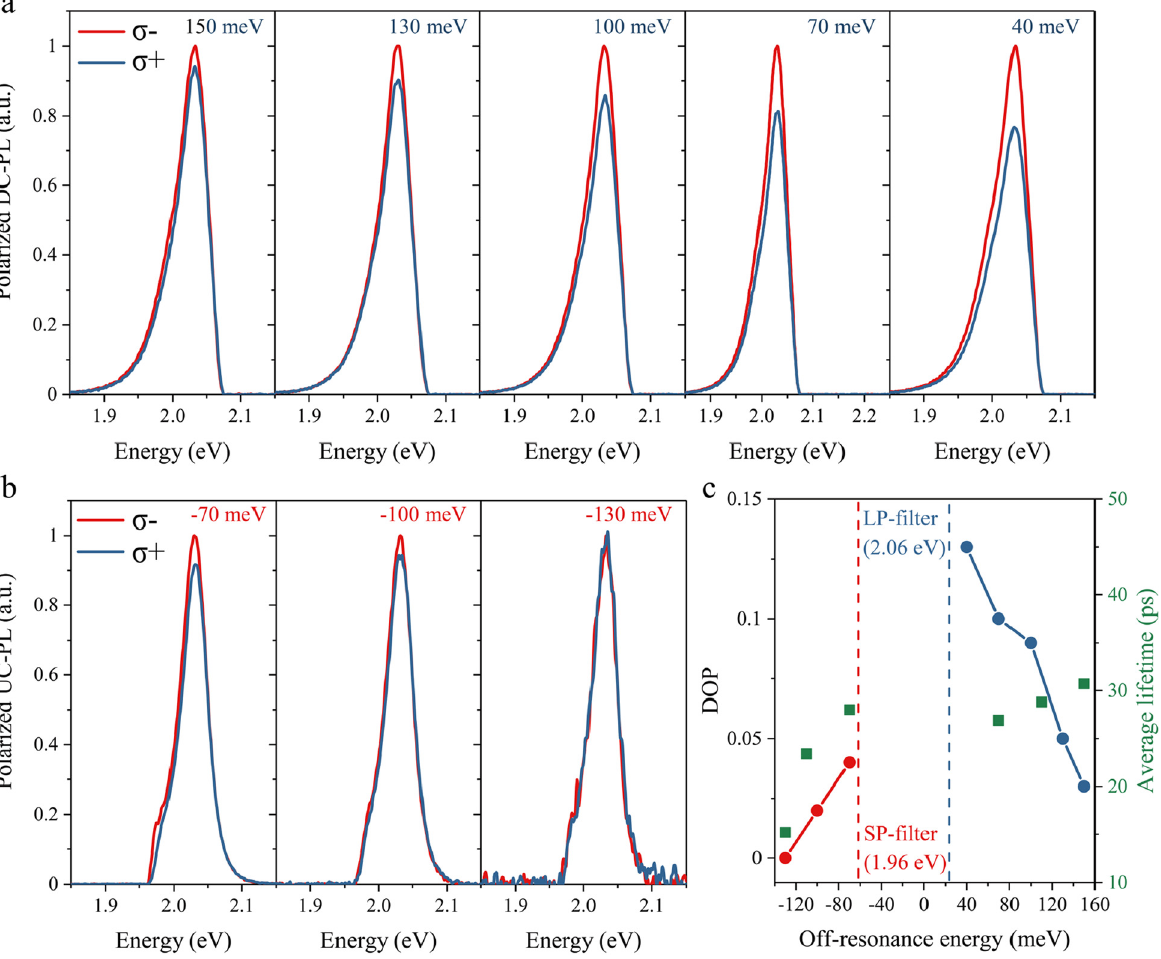
Figure 4: Polarized photoluminescence (PL) spectra and average lifetime of A-excitons in downconversion (DC) and upconversion (UC) scenarios. (a)PolarizedPLspectrainDCprocess.(b)PolarizedPLspectrainUCprocess.(c)Degreeof polarization(DOP)valueandlifetimeof